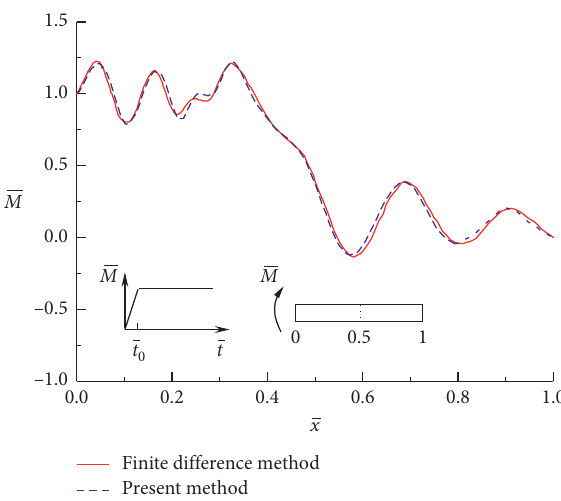
Figure 5: Moment distribution along the length of the uniform beam at t �